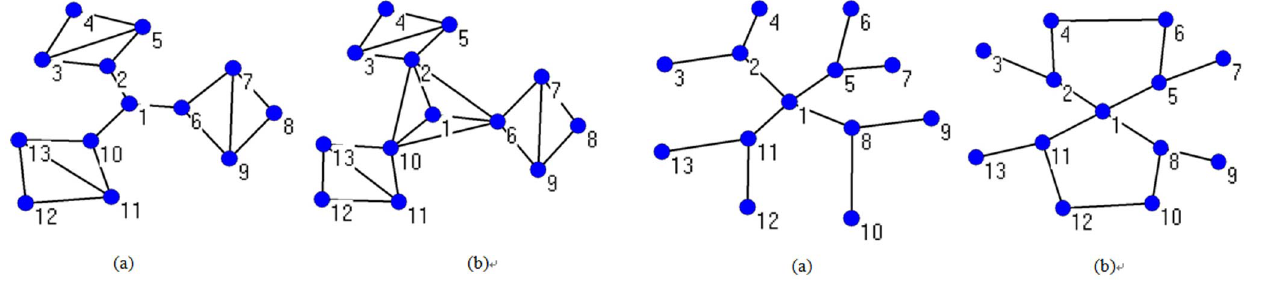
Figure 3. Comparisons of the value between closeness and bridge role in two identical networks. (a) N =13 and M =18. (b) N =13 and M =21, where there are three more edges in this network on the basis of the network in (a). Node 1 is in the center in these two networks.